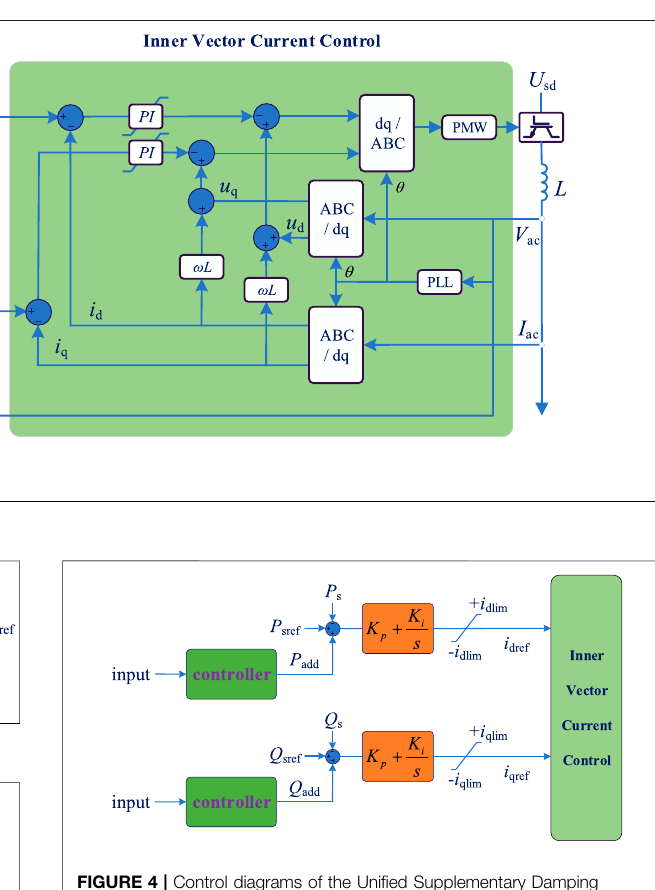
FIGURE 4 | Control diagrams of the Uni fi ed Supplementary Damping control for VSC.